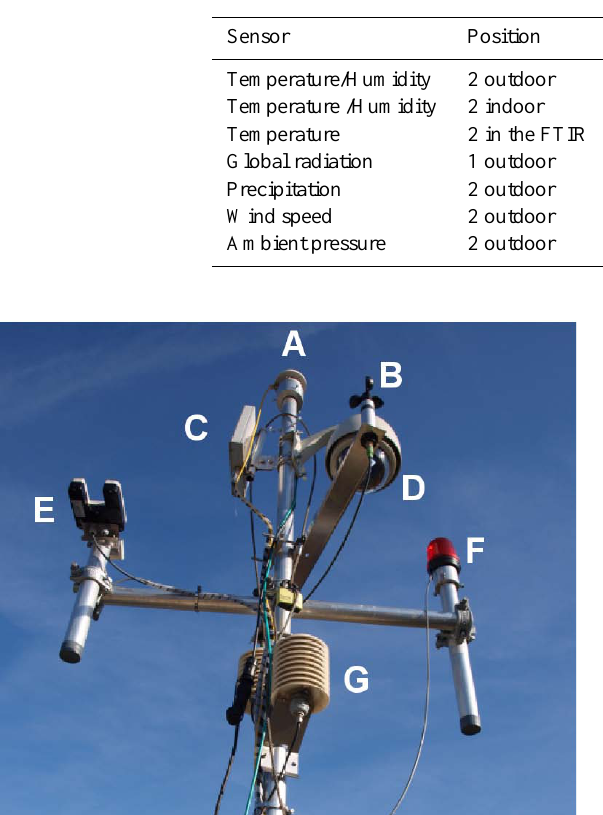
Table 1. Weather station equipment.